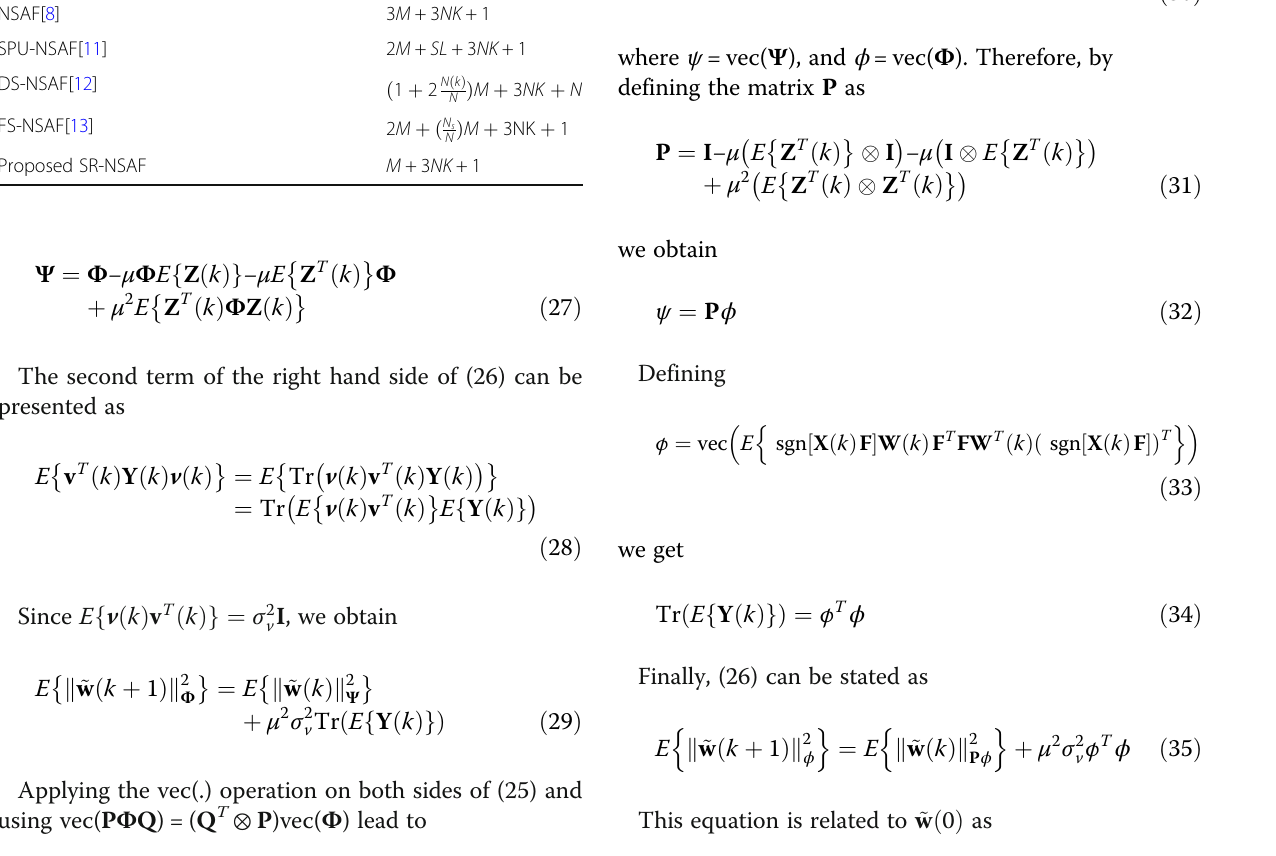
Table 4 Computational complexity of the family of NSAF algorithms